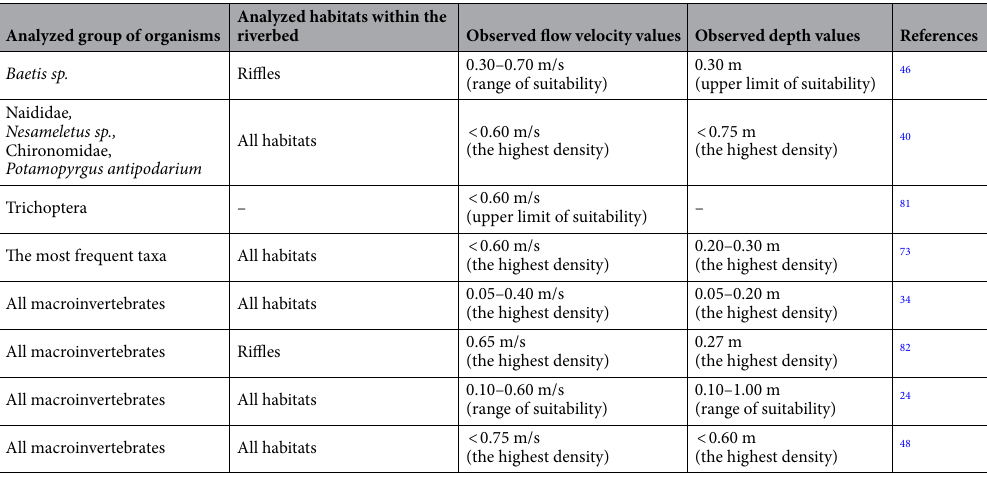
Table 1. Synthesis of optimal and suitable water flow velocity and depth values for macroinvertebrates based on